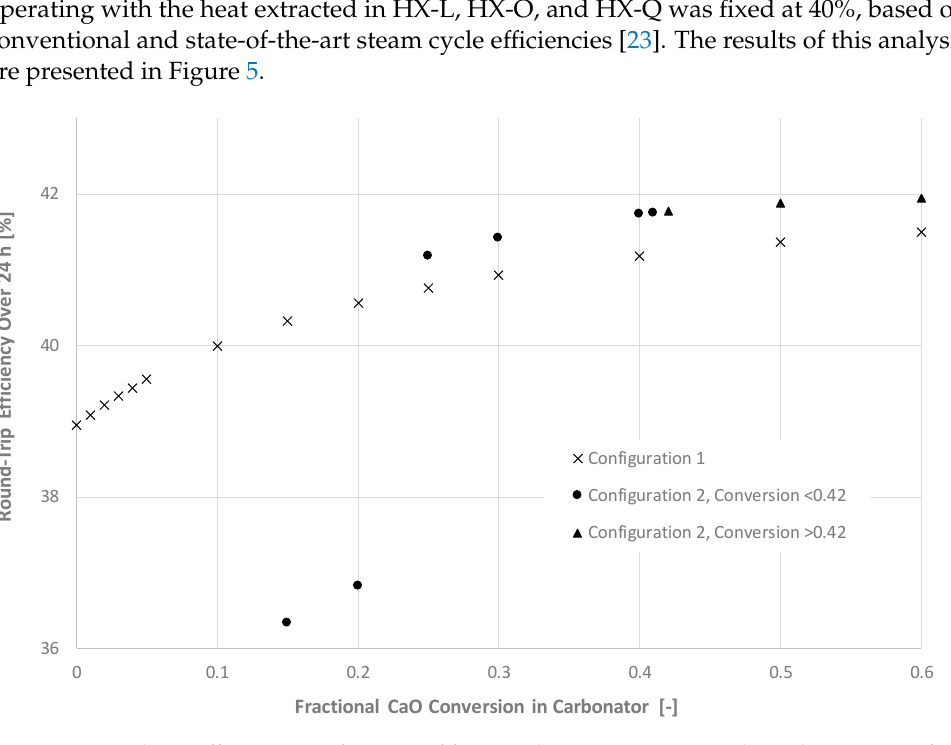
Figure 5. Round-trip efficiency as a function of fractional CaO conversion in the carbonator, Configuration 1 vs. Configuration 2.